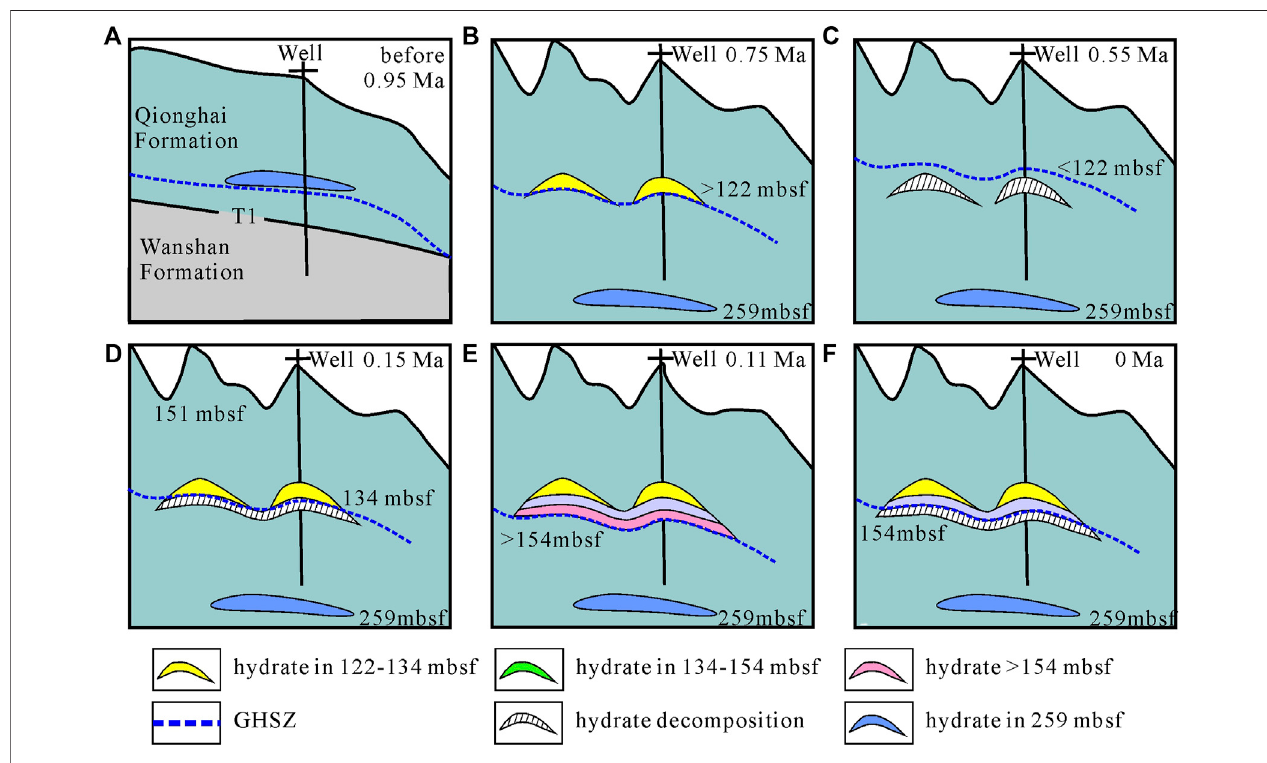
FIGURE 10 | Schematic diagram of the dynamic hydrate accumulation process at 122 – 151 m at site SH-W07-2016. (A) before 0.95 Ma. (B) 0.75 Ma. (C) 0.55 Ma. (D) 0.15 Ma. (E) 0.11 Ma. (F) 0 Ma.